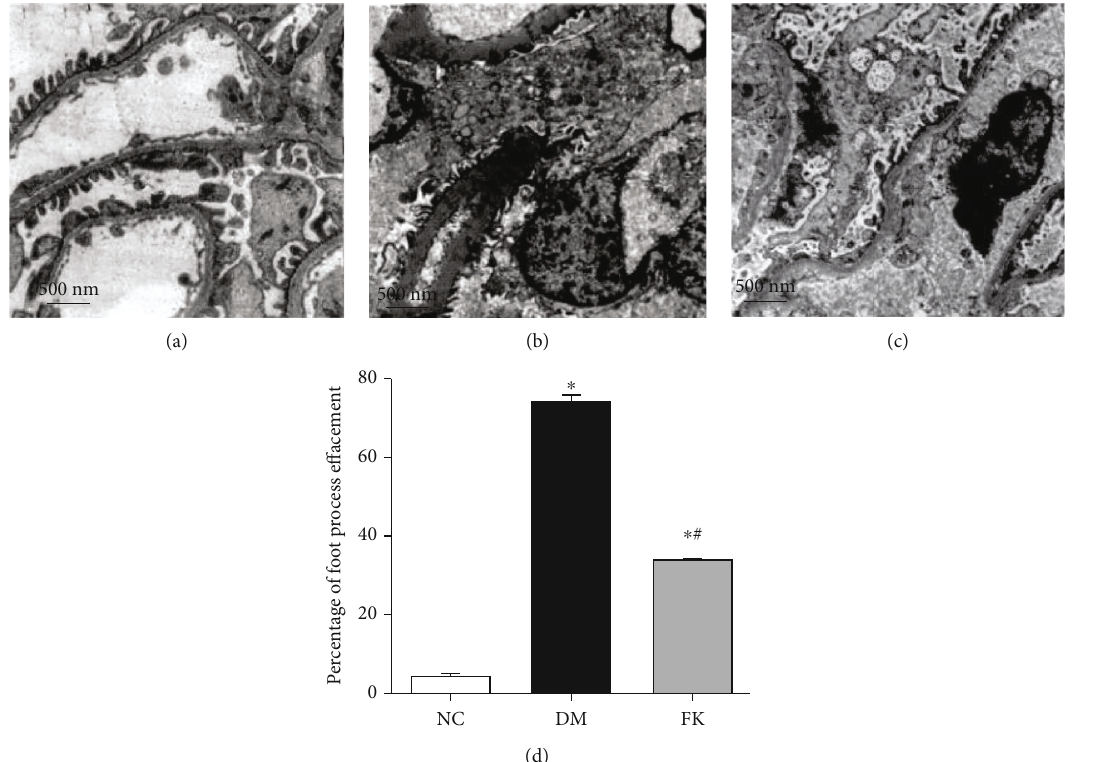
Figure 3: E ff ects of FK506 on ultrastructural variations of podocyte in DN rats. Three groups were included in this morphological observation, (a) NC group, (b) DM group, and (c) FK group, and the FK506 treatment improved the impaired ultrastructure of podocytes and foot process fusion rate (d) in DM rats. ∗ P < 0 : 05 compared to the NC group, ∗ # P < 0 : 05 compared to the DM